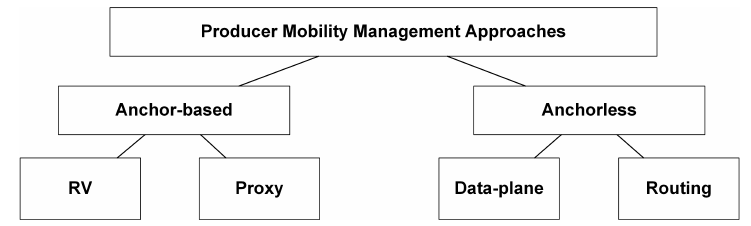
Figure 1. Producer mobility management in the